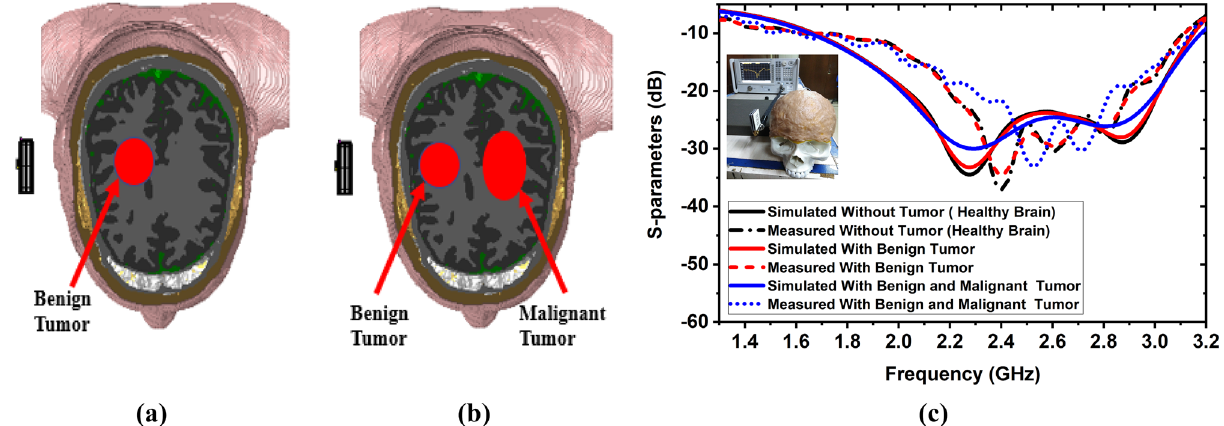
Figure 18. Simulated and measured results with head model including tumors: ( a ) Head model with a benign tumor; ( b ) Head model with a benign and a malignant tumor; ( c )